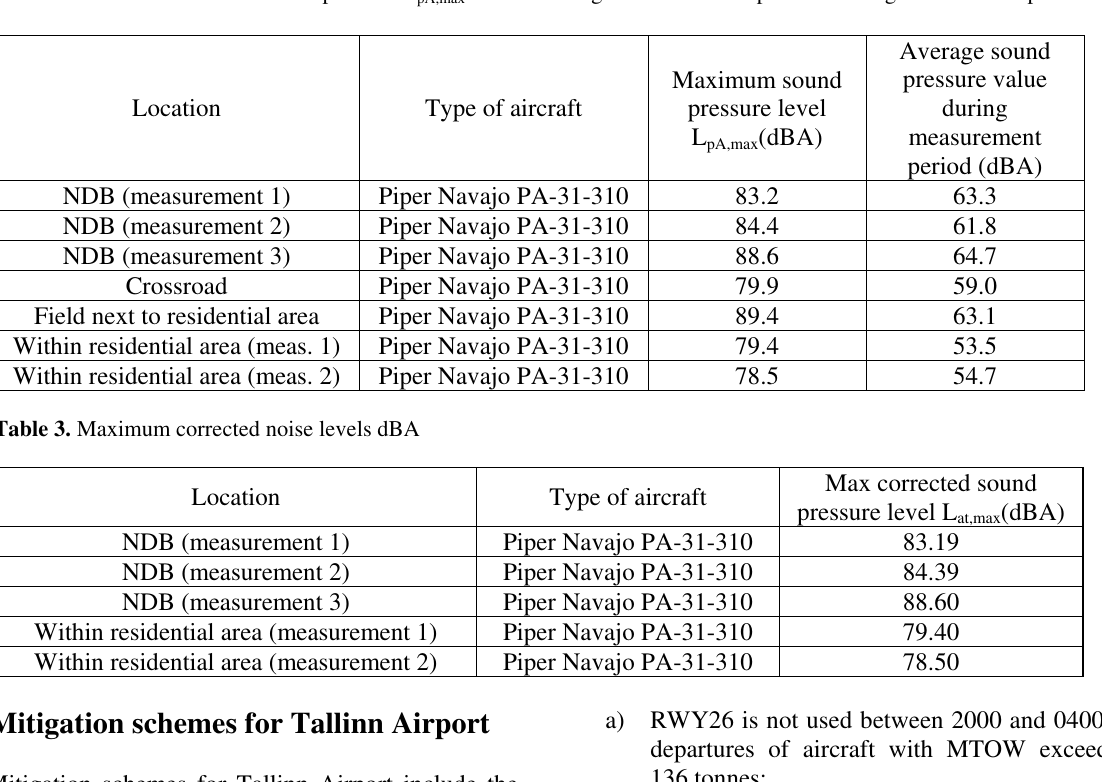
Table 2. Maximum values of sound pressure L pA,max and the average value of sound pressure during measurement period